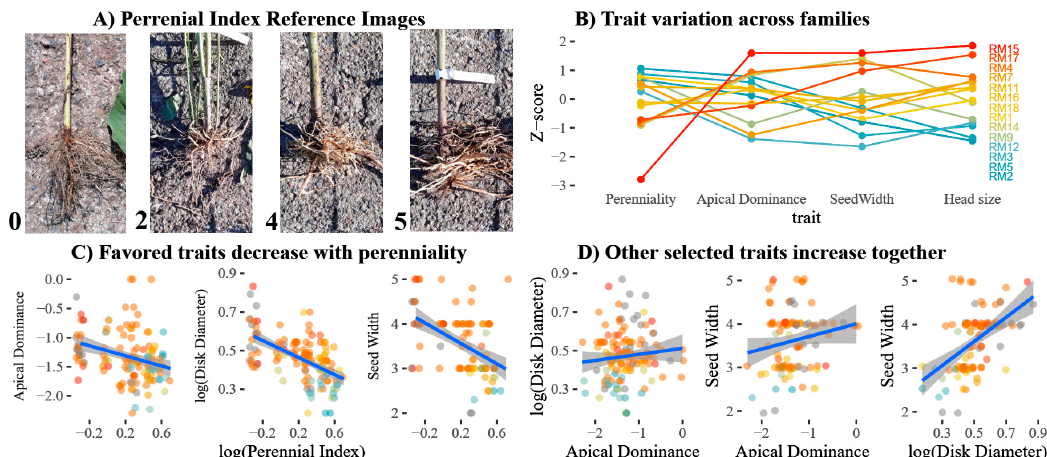
Figure 4. (A ) Examples of below-ground morphologies scored by perennial index, increasing from left to right: H. annuus with a score of 0, two hybrids with scores 2 and 4, and H. tuberosus with the maximum score of 5. Tubers, the overwintering structure, appear as swollen, light-colored “roots”. Relationships between favored traits of hybrids ( B ) by maternal line, ( C ) compared to perenniality, and ( D ) compared across domesticated annual phenotypes. B–C: Colors indicate maternal line.